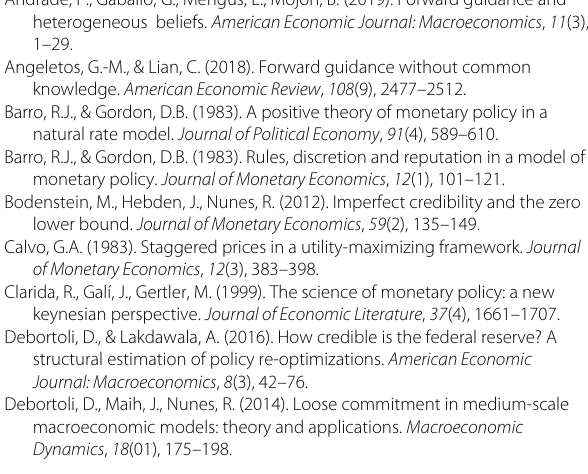
in the output gap. Both is because agents are more will- ing to adjust their expectations if policy commitment are expected to be honored with a higher probability and/or over a longer horizon. The higher the future expected cen- tral bank credibility, the lower the cost of implementing policy commitments